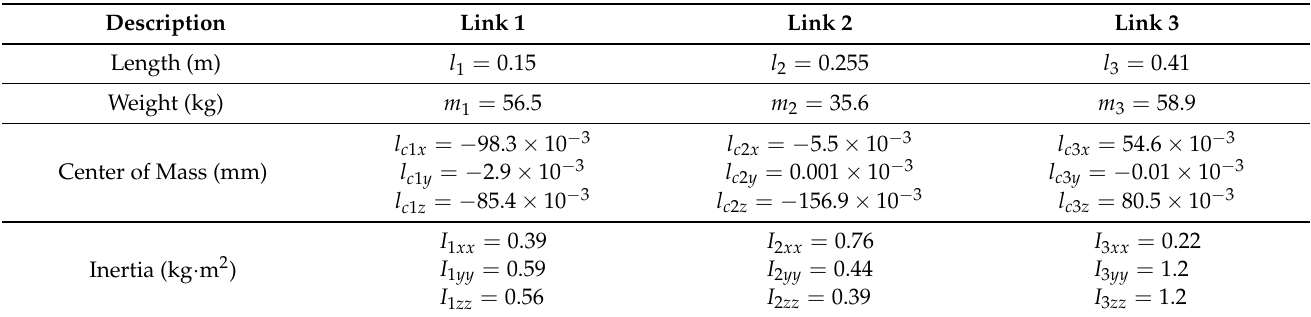
Table 1. Essential parameters for the design of a FARA-AT2 robot.